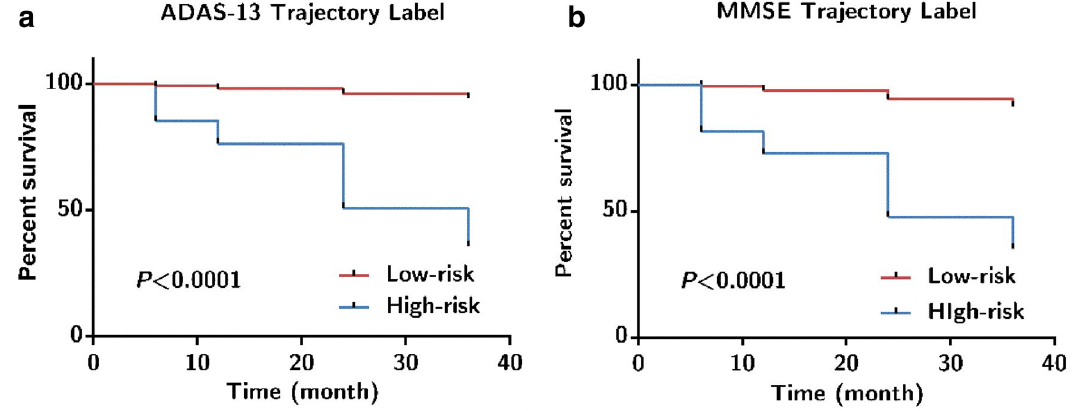
Figure 3. Kaplan–Meier curves for 3-year progression to AD in MCI based on ADAS-13 (N = 110) and MMSE (N = 92) predictive dataset. ( a ) ADAS-13 Trajectory Label; ( b ) MMSE Trajectory